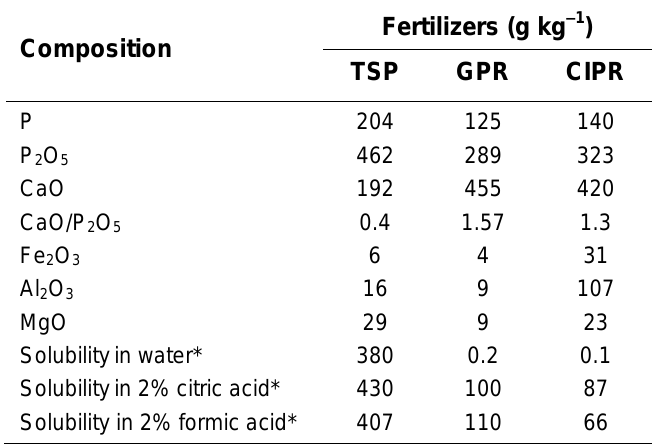
Characteristics of the Fertilizers Used